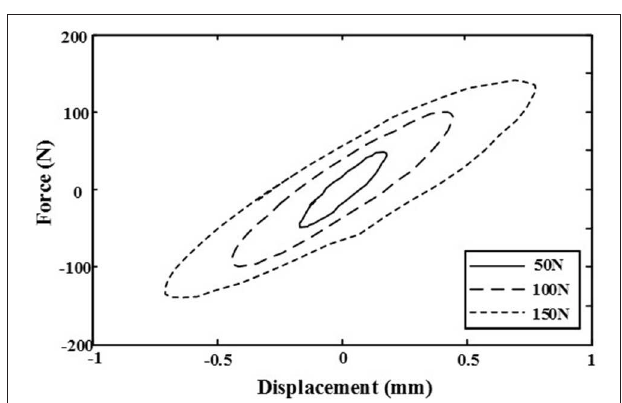
FIGURE 7 | Force-displacement hysteretic curve of the viscoelastic